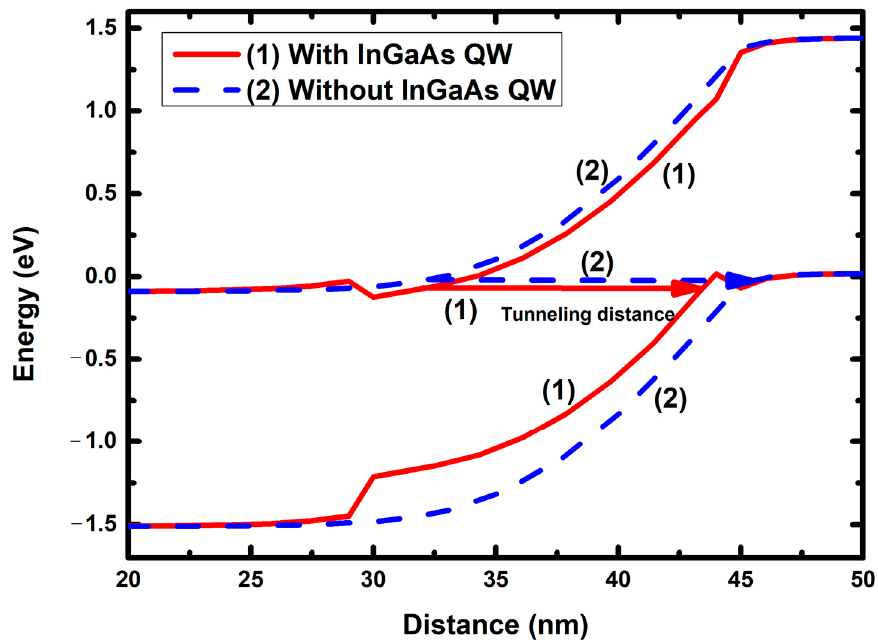
Figure 1. Band structure of ( 1 ) p ++ -GaAs // n ++ -In 0.07 GaAs / n ++ -GaAs (solid line) and ( 2 ) p ++ -GaAs / n ++ -GaAs (dashed line) tunnel junctions. The di ff erences in band bending shorten the tunneling distance for the InGaAs quantum well inserted in the GaAs tunnel junction structure.